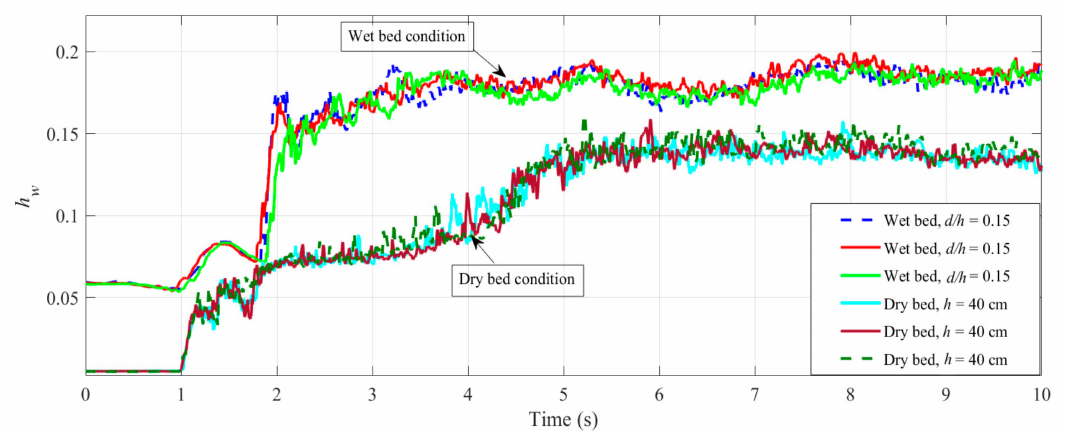
Figure 4. Repeatability of tests for water level time history (WG2), with various water depth ( h ) values of dry bed condition and d / h values of the wet bed condition.